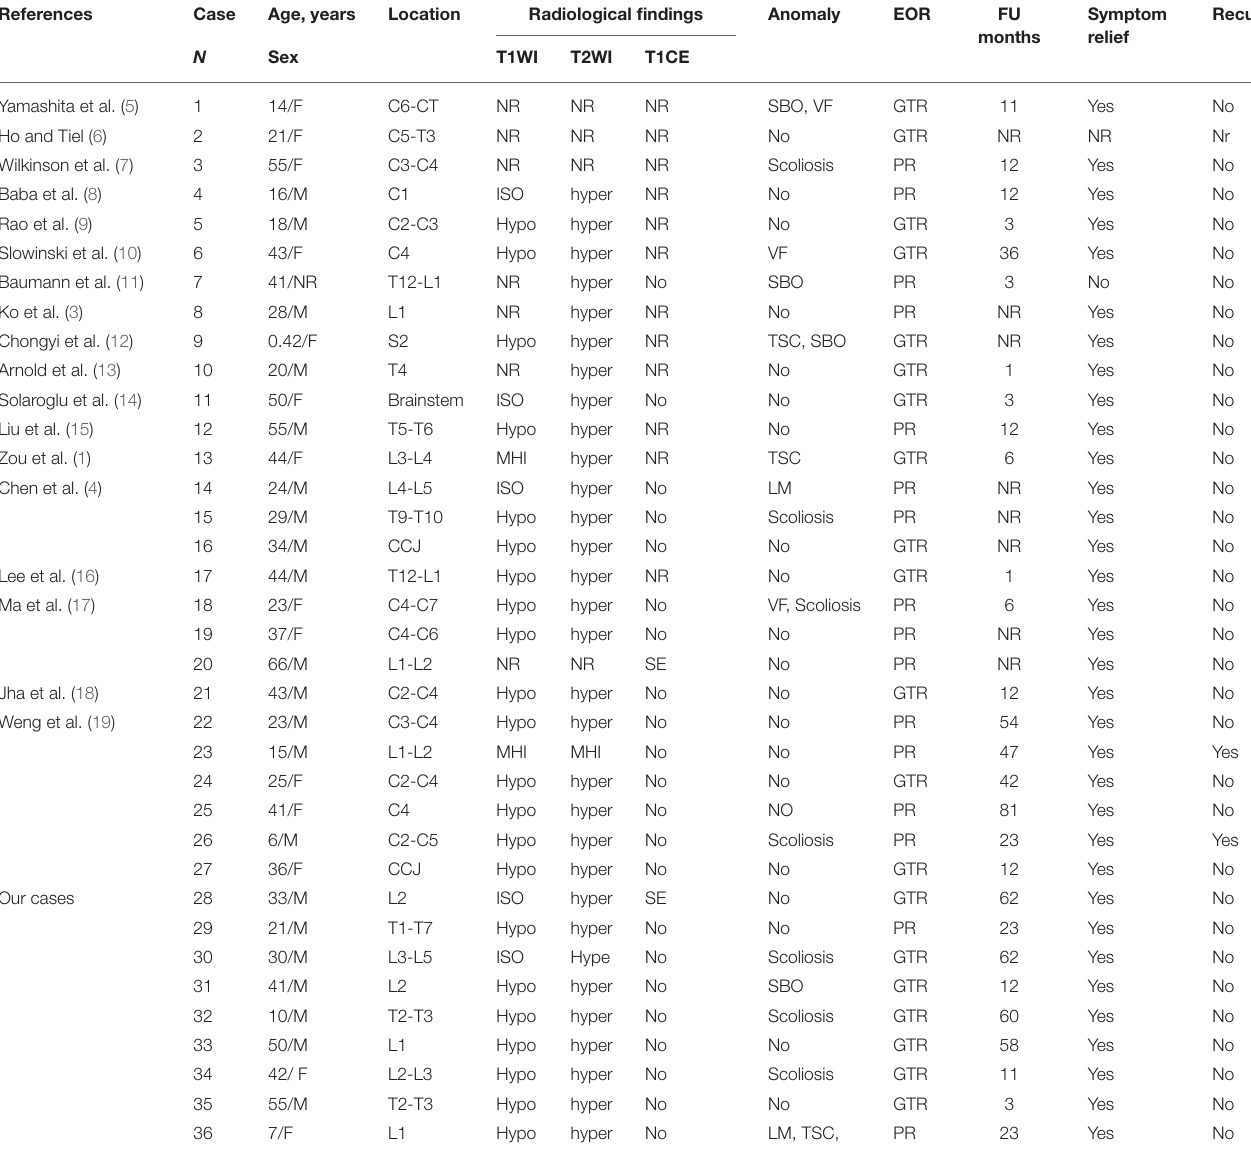
TABLE 2 | Summary all the cases of